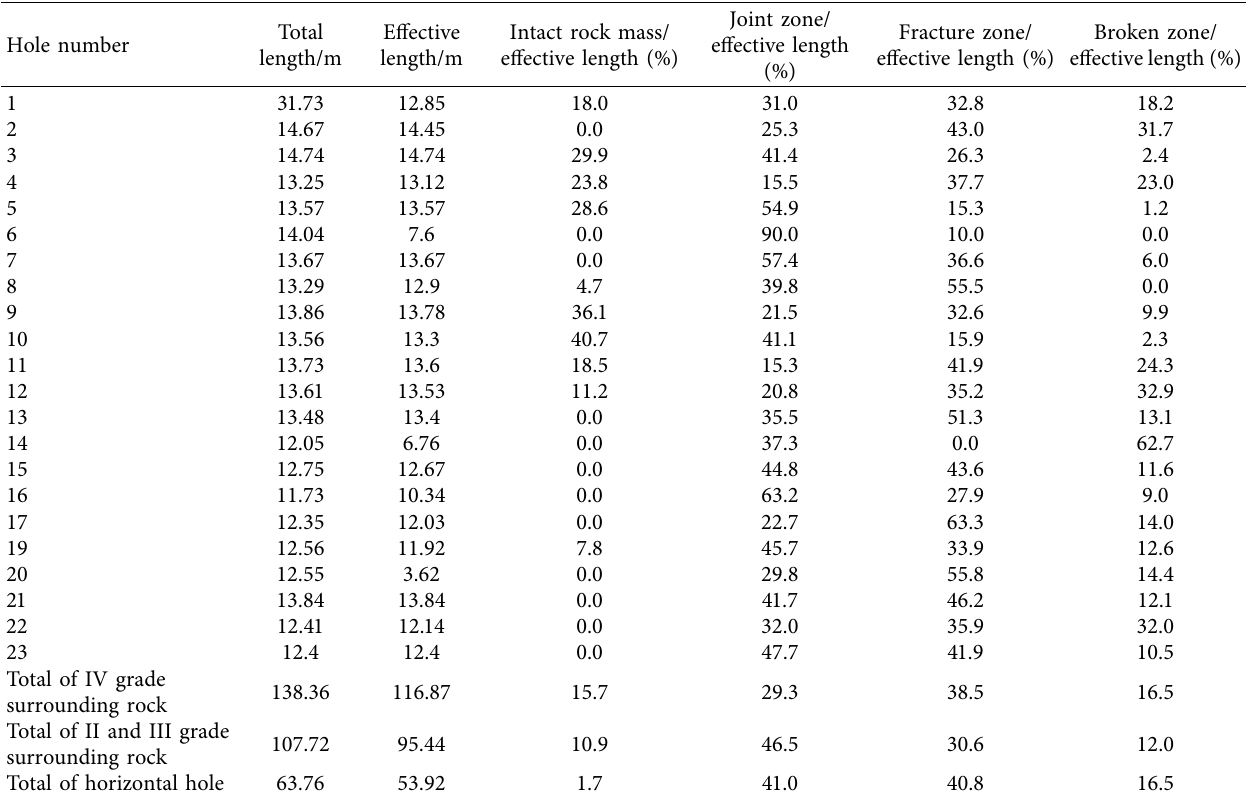
Figure 11: Image of horizontal hole. (a) Hole No. 13. (b) Hole No. 20. (c) Hole No. 21. (d) Hole No. 22. (e) Hole No. 23. Table 3: The percentage of effective length of each partition and its percentage in the effective length of corresponding